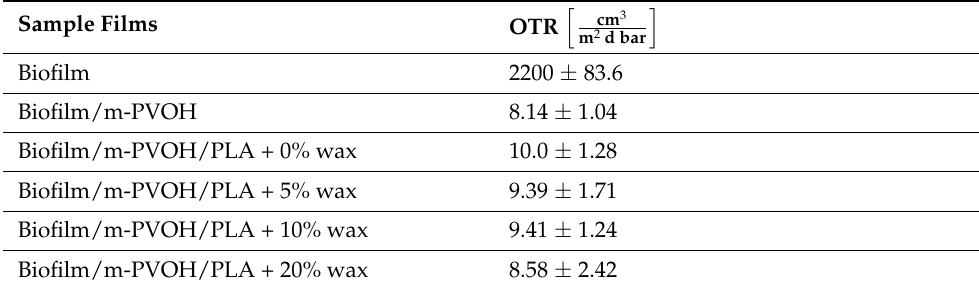
Table 4. Oxygen transmission rate (OTR) for neat Biofilm and all multilayer films. Sample